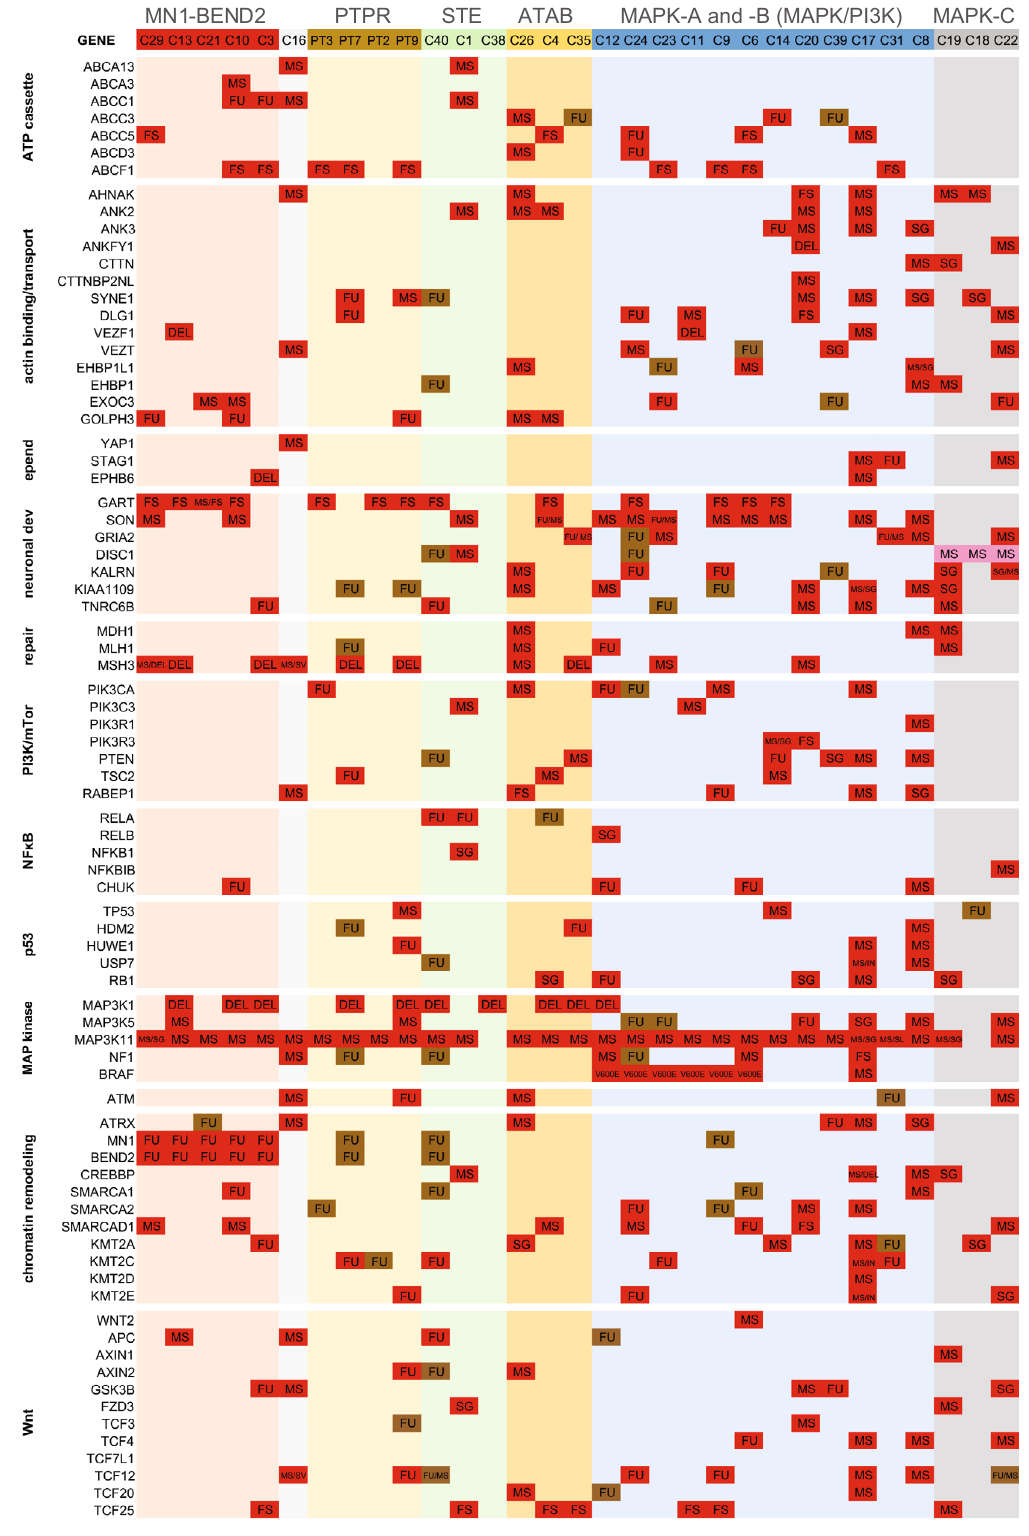
Fig. 2 Gene mutations and fusions segregate AB-like tumor genetic groups. Pathway gene alterations across AB-like tumors, ATAB, PTPR and RELA STE are grouped. Missense = MS, splice region variant = SV, stop gained = SG, stop lost = SL, frameshift = FS, deletion = DEL, insertion = INS, fusion = FU, PT = PTPR. Detected genetic alterations are highlighted in red. Brown cells indicate fusions detected by only one read. Pink indicates a FathmmMLK score <0.5, but predicted to be damaging by PolyPhen or deleterious by SIFT. Source data: Supplementary Data 1 and